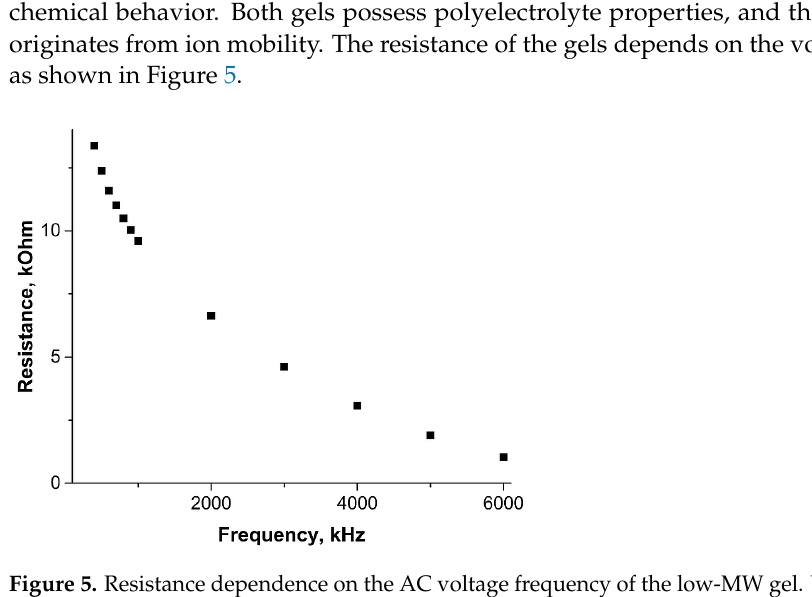
Figure 5. Resistance dependence on the AC voltage frequency of the low-MW gel. Voltage ampli- tude 35 mV, thickness of the sample 230 μ m, cross-section 5 × 5 mm.